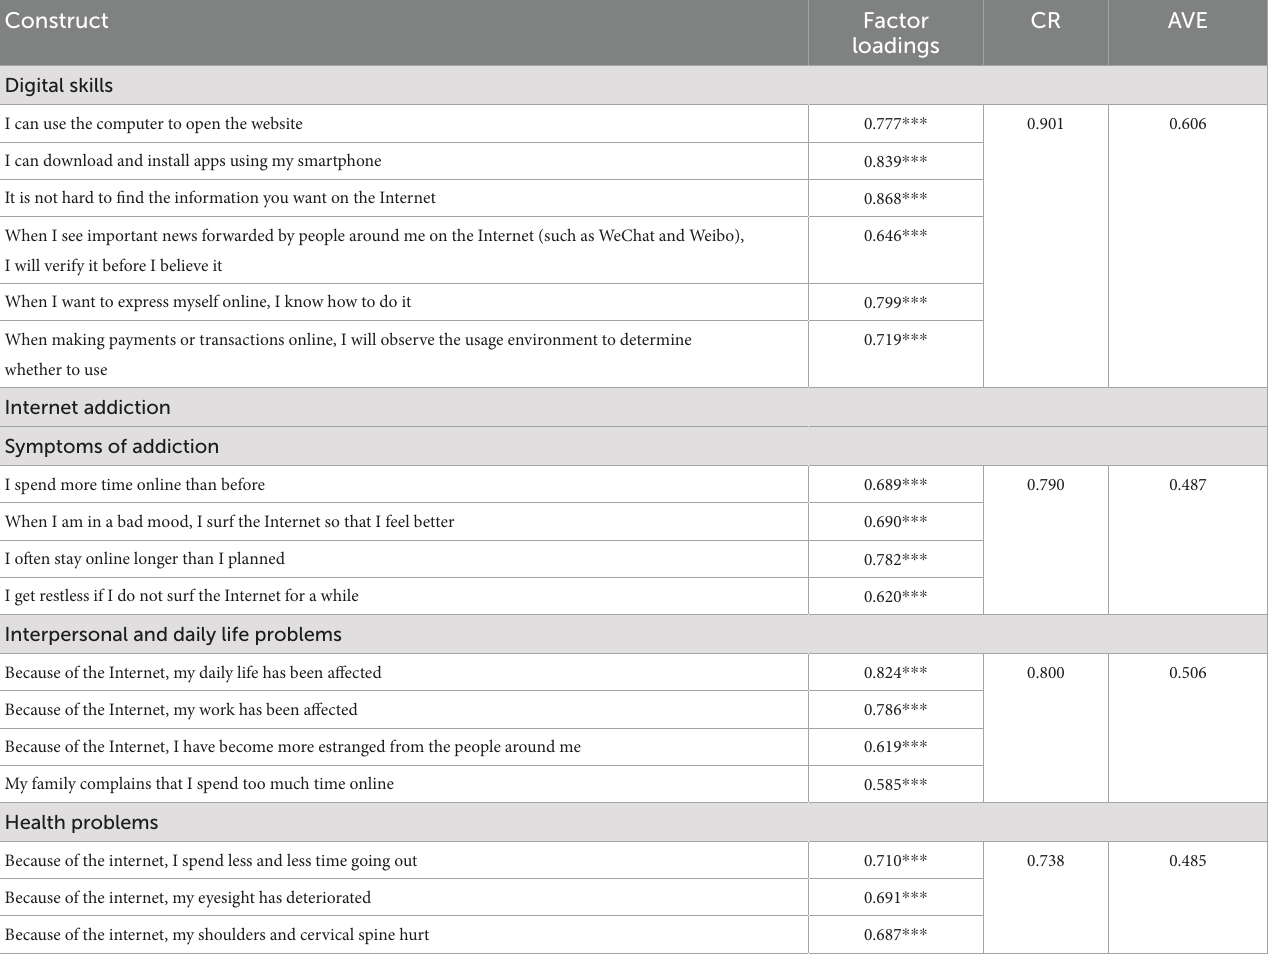
TABLE 1 Reliability and validity test of the scale and confirmatory factor analysis properties.